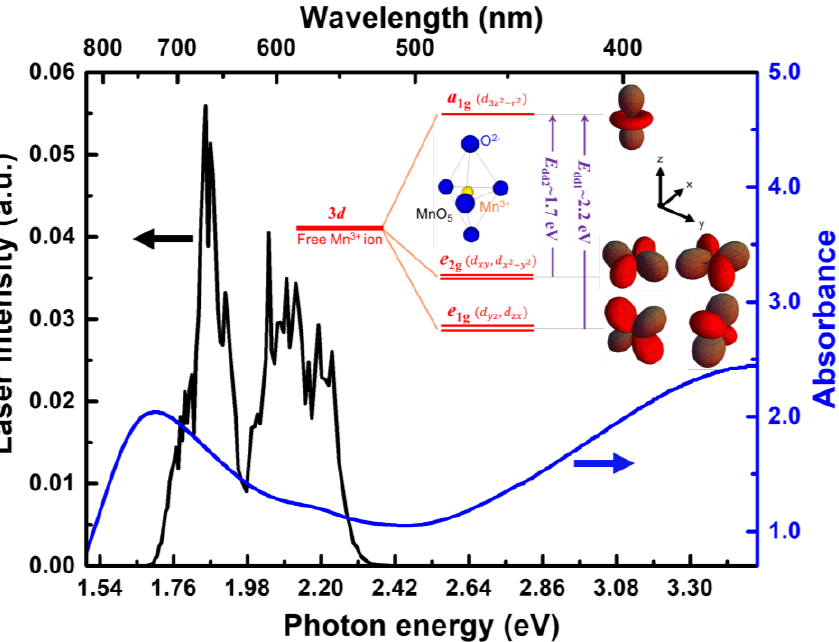
Figure 1. Stationary absorption spectrum of a hexagonal HoMnO 3 thin film and the laser spectrum used in this study. The inset shows the electronic levels of the five-fold coordinated Mn 3+ ion in the MnO 5 trigonal bipyramidal field of the five surrounding O 2 − ligands.